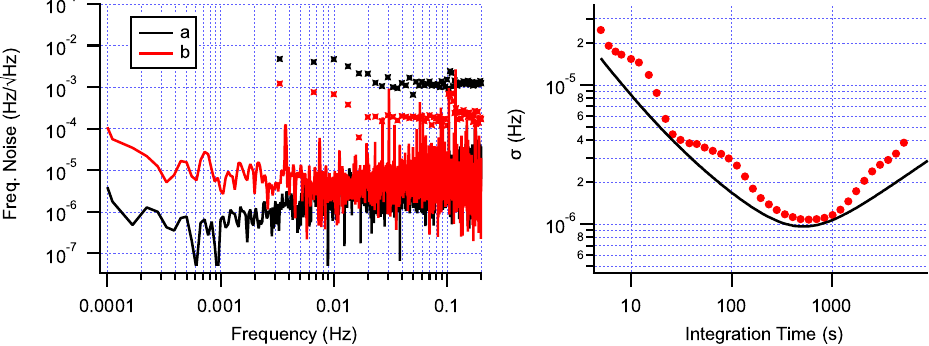
(cid:113) ( Γ a ) 2 + f 2 . 2